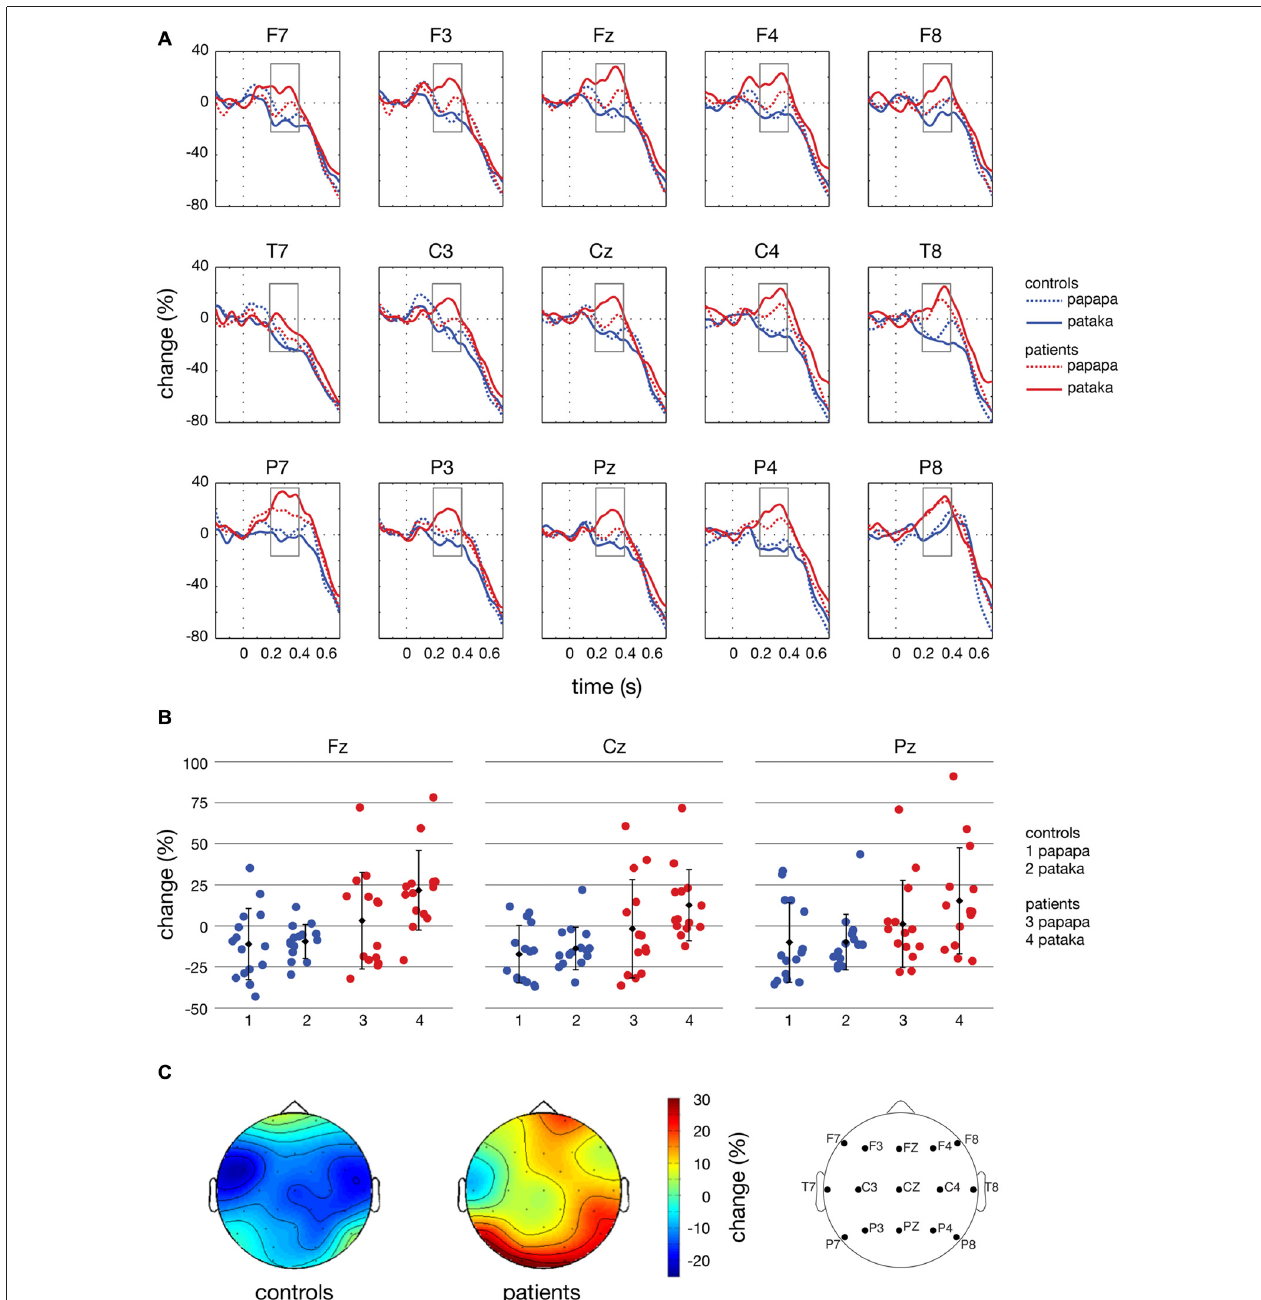
FIGURE 7 | Time courses, individual changes and topographies of spectral power in the β -band. (A) shows averaged time courses of spectral power in the β -band (16–31 Hz) relative to a baseline period of − 100 to 0 ms for controls (blue lines) and patients (red lines). Dashed lines depict the papapa condition, solid lines the pataka condition. Time (in seconds) is shown on the x -axis; the vertical line at 0 s represents the onset of the visual cue. Relative change (in % of the baseline value) is shown on the y -axis. The boxes represent the time window (200–400 ms) of the ANOVA. (B) demonstrates the changes in β -band power relative to the baseline for each individual participant, averaged across the time window of 200–400 ms. Healthy controls are shown in blue (1: papapa condition; 2: pataka condition), patients with PD are shown in red (3: papapa condition; 4: pataka condition). Data were plotted for the central electrodes Fz, Cz and Pz. The black diamonds represent the group mean, the error bars the standard deviation. (C) displays the topographical distribution of changes in spectral power in the β -band relative to the baseline in controls and patients. For each topological plot, the average of the papapa and pataka condition was